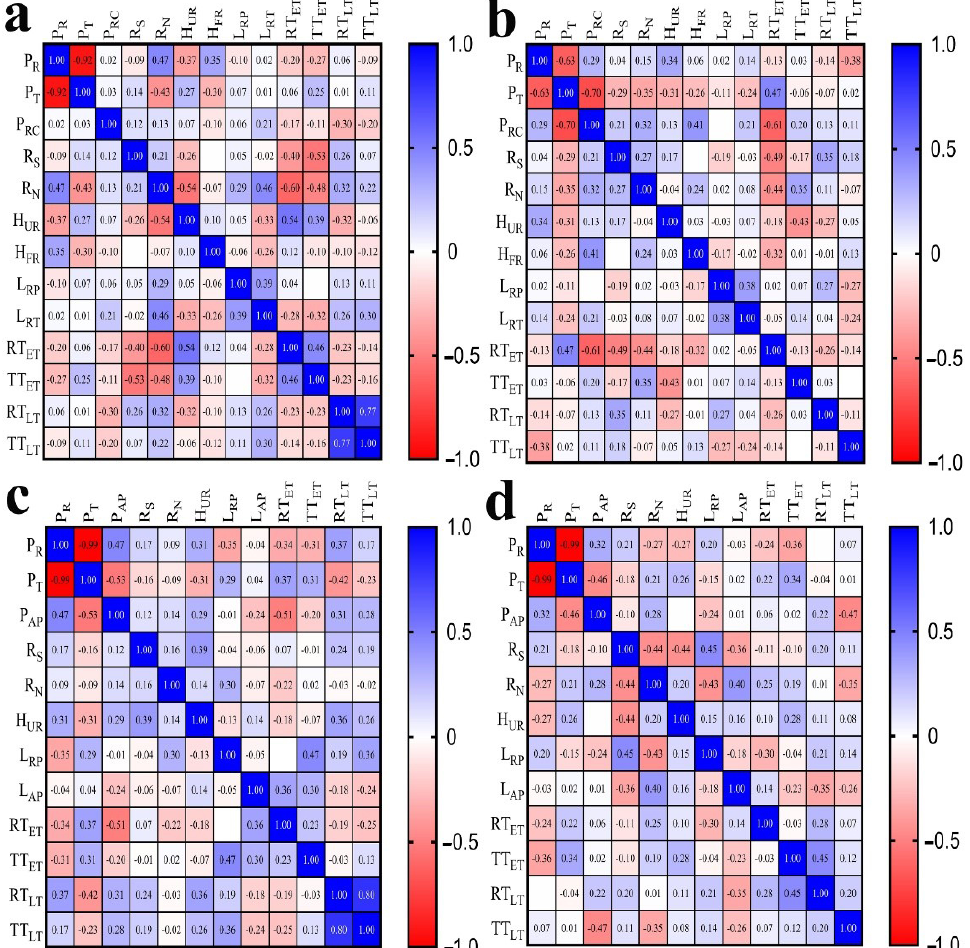
Figure 3. Correlation coefficients calculated amongst wood anatomical features for Masson pine and Chinese fir. ( a ) Juvenile Masson pine, ( b ) mature Masson pine, ( c ) juvenile Chinese fir, ( d ) mature Chinese fir.